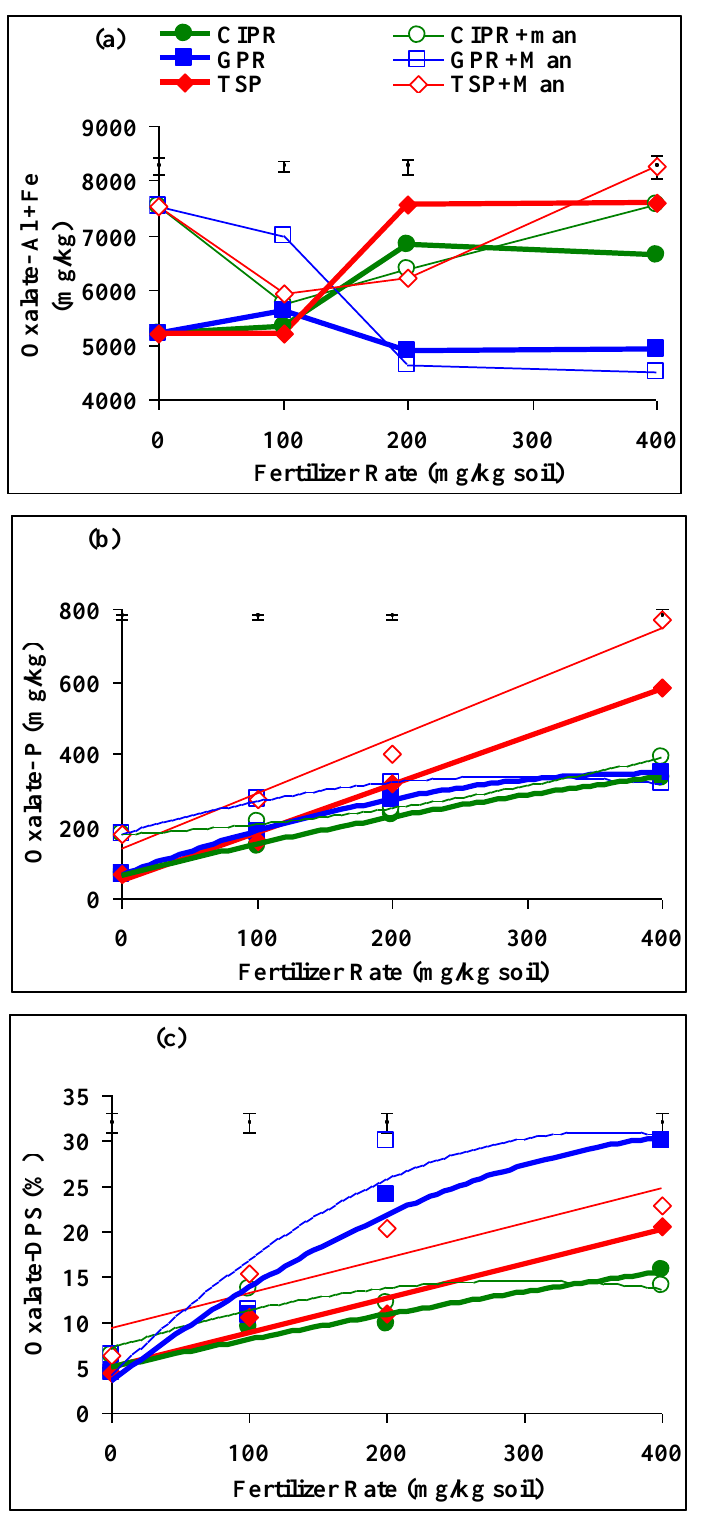
FIGURE 1. Effects of P source  P rate  manure on (a) oxalate Al + Fe, (b) oxalate P, and (c)